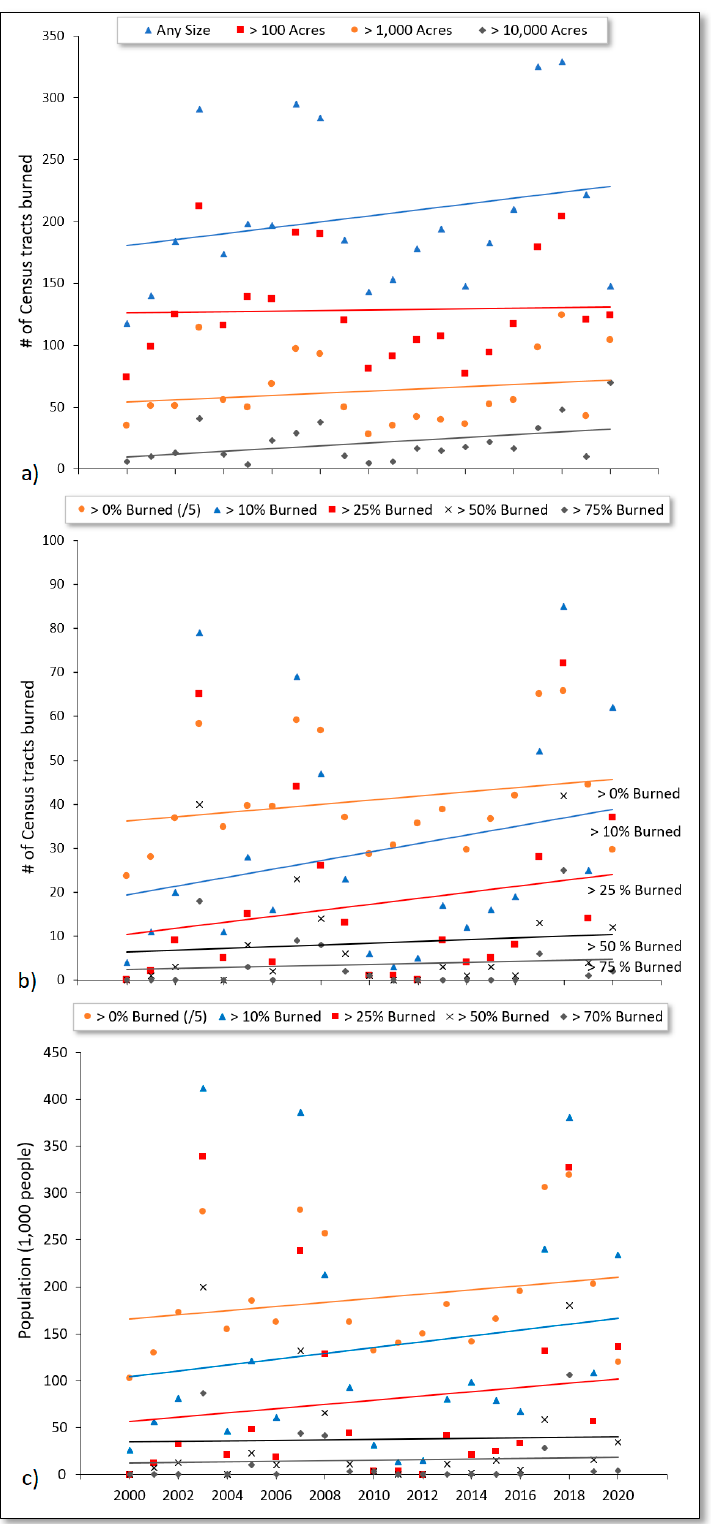
Figure 2. Annual time series of the ( a ) number of Census tracts that incurred different percentages of burned area, ( b ) number of Census tracts burned by wildfires of varying sizes, and ( c ) cumulative population of those residing in Census tracts affected by wildfires from 2000–2020. For the Census tract “>0% burned” category, y -axis values were divided by 5 to adjust for differences in scale and enable a side-by-side comparison of